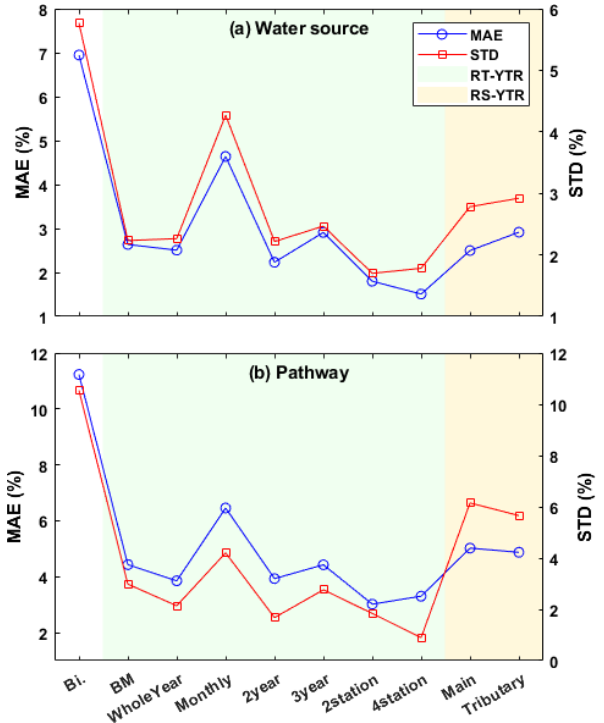
Figure 10. Accuracy and uncertainty metrics of estimated CRCs in the YTR basin derived from the different stream water sampling strategies (Experiment 3). (a) For CRCs quantified under the defini- tion of water source and (b) for CRCs quantified under the definition of runoff